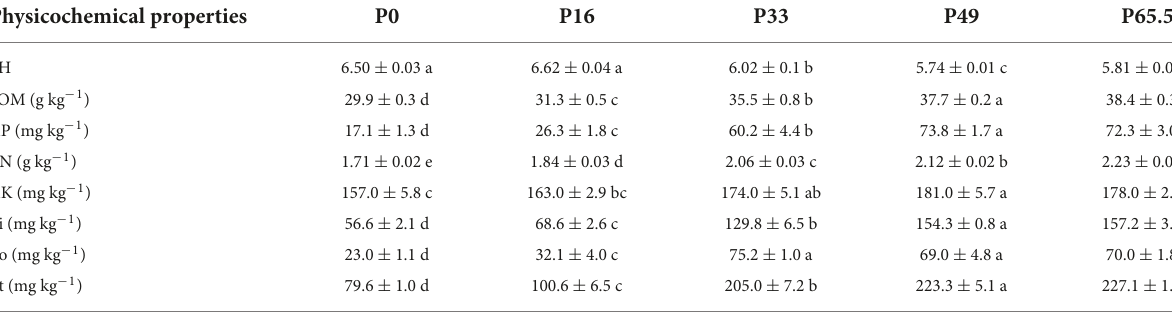
TABLE 1 Physicochemical properties of acidic purple soil under gradient P fertilization rate. Physicochemical